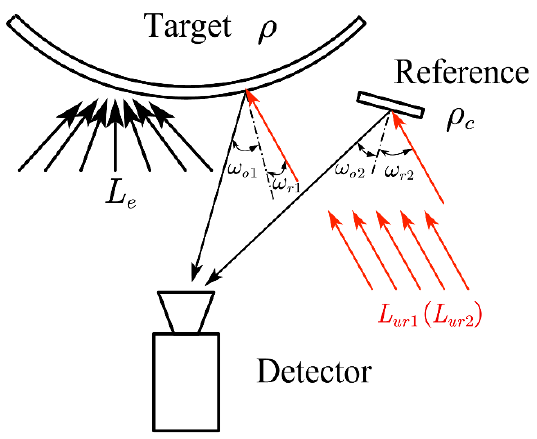
Figure 6. Schematic diagram of the measurement scene under uniform irradiation.